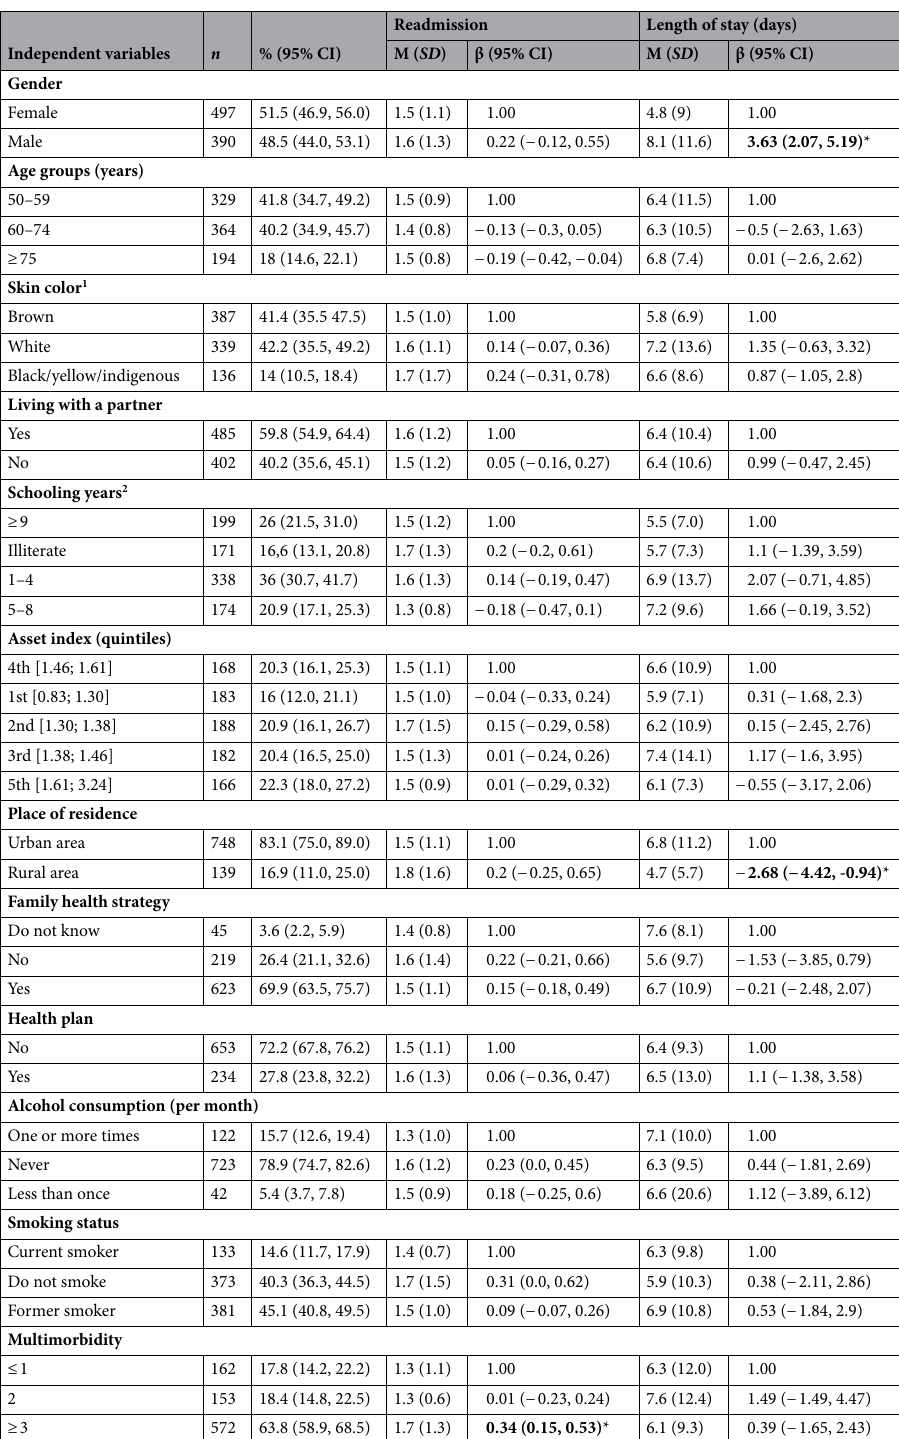
Table 2. Average readmission and length of stay and their association with sociodemographic, lifestyle and multimorbidity variables in older adults from the ELSI-Brazil cohort (2015–2016). 95% CI 95% confidence interval, n unweighted number of observations. Relative frequencies (%) and weighted confidence intervals. M mean, SD Standard deviation. 1 n = 862. 2 n = 882. * p <